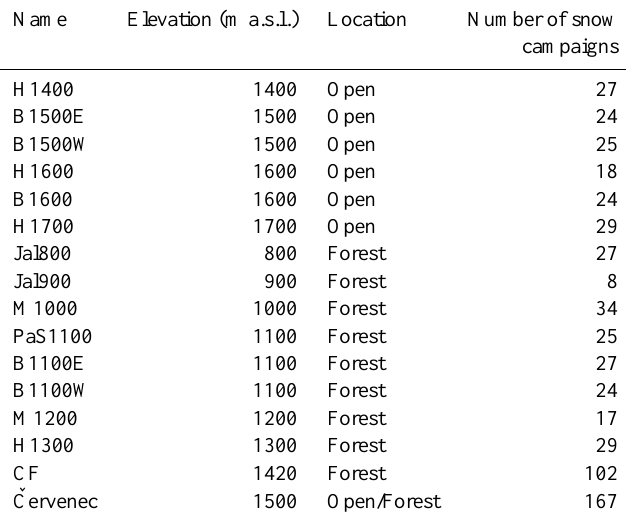
Table 1. Number and location of snow measurements at each snow profile in the period 2000–2011.